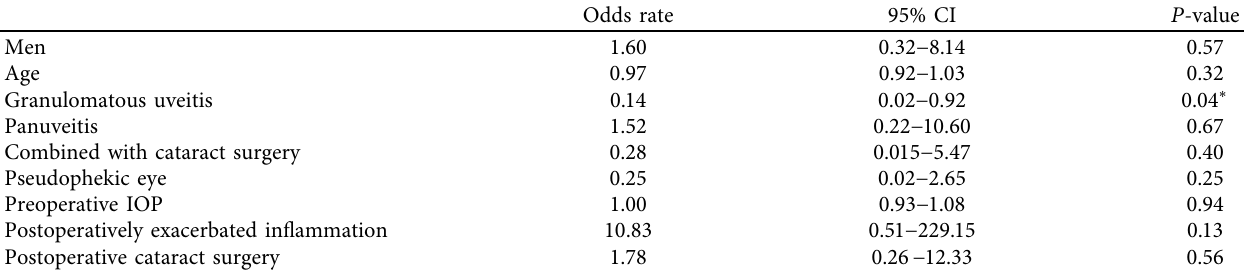
Table 6: Multivariate logistic regression analysis of the risk factors for surgical failure at 10 years in UG Odds rate 95%